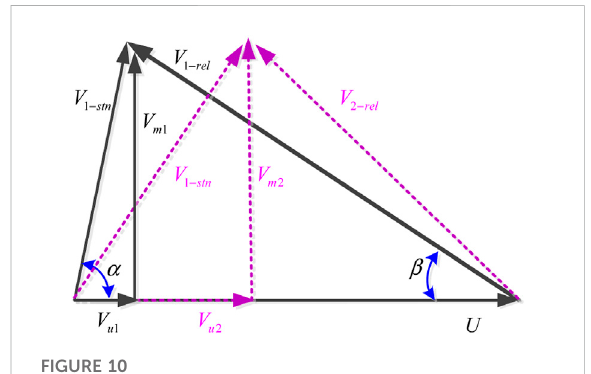
FIGURE 10 The velocity triangle at the impeller inlet and